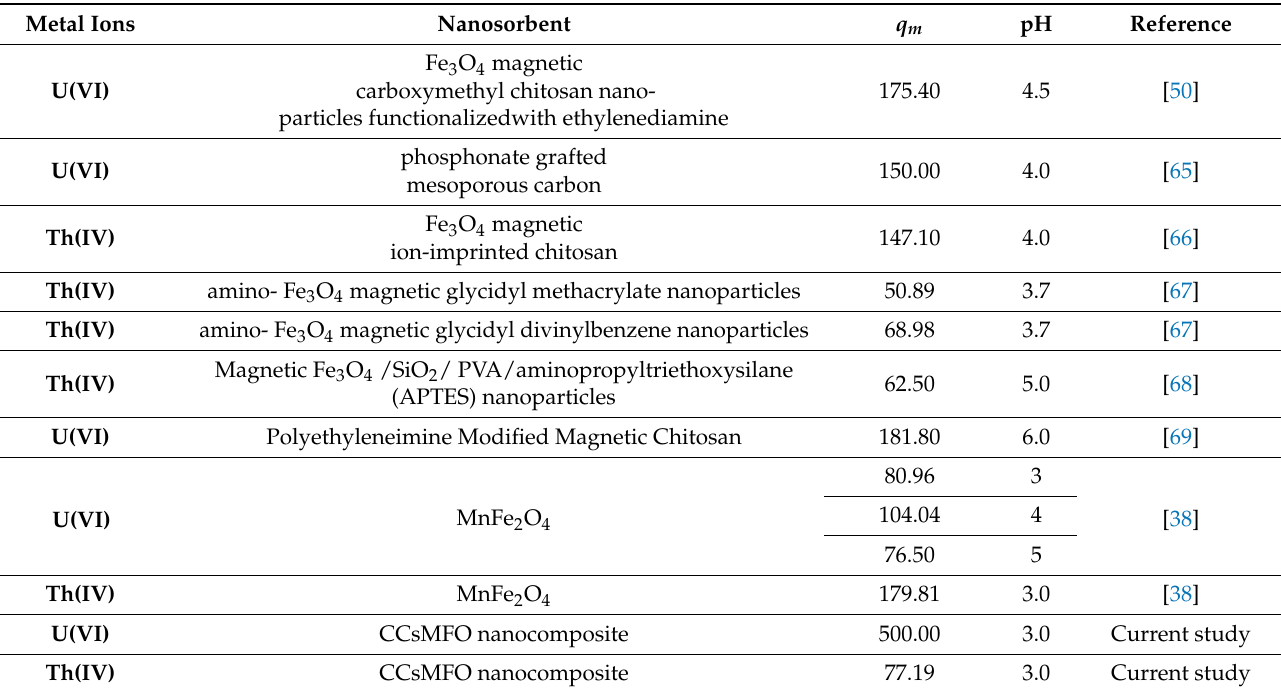
Table 6. Maximum adsorption capacity q m (mg/g) of U(VI) and Th(IV) on different nanosorbents with present work MnFe 2 O 4 NPs at 25 ◦